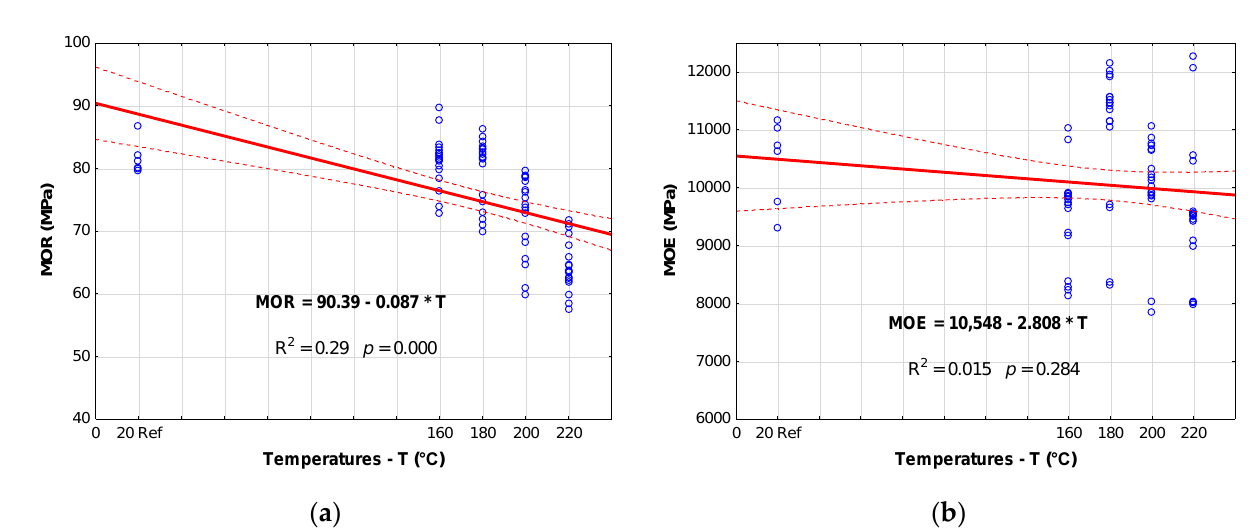
Figure 5. Summary linear correlations between the bending characteristic MOR ( a ) or MOE ( b ) of the three-layer glulam beams belonging to the 2nd, 3rd and 4th groups and the temperature during the artificial aging of spruce lamellas.